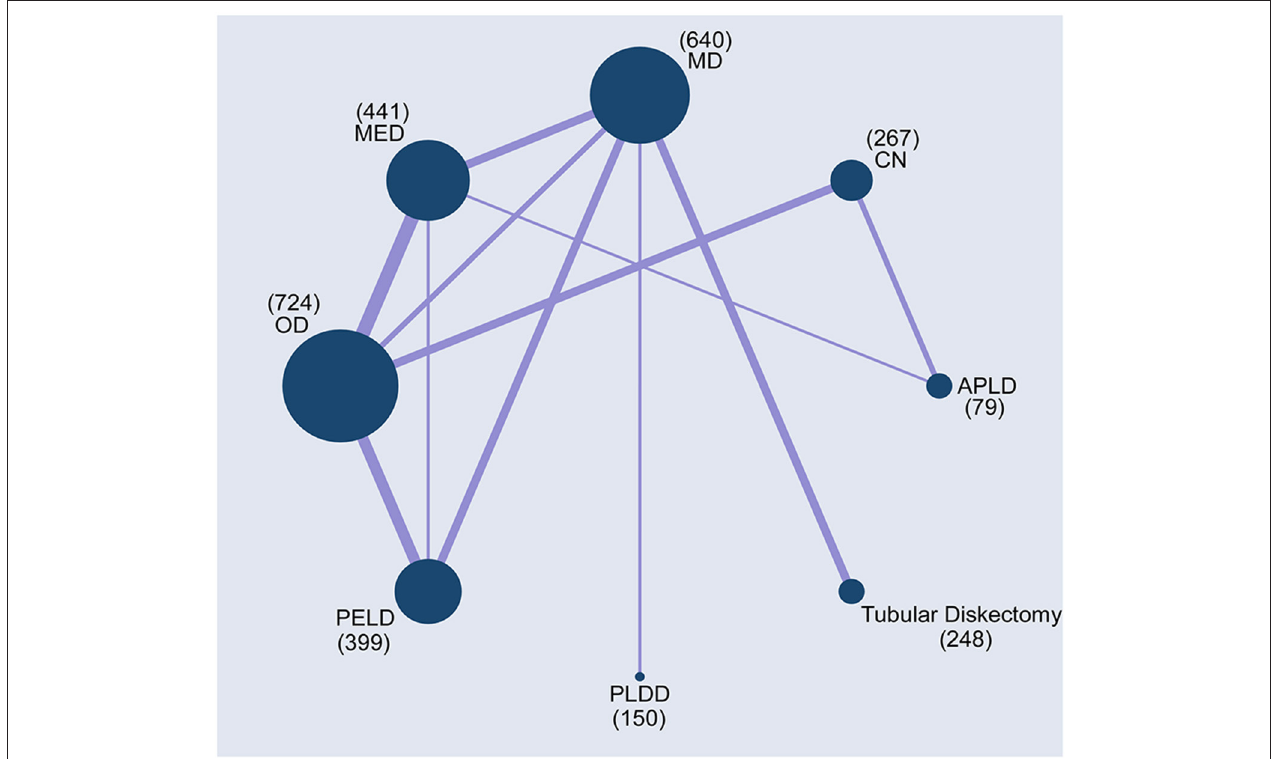
FIGURE 2 | Network plots of comparisons based on network meta-analysis (NMA). Each circular node represented a type of treatment. The circle size is proportional to the total number of patients. The width of lines was proportional to the number of studies performing head-to-head comparisons in the same